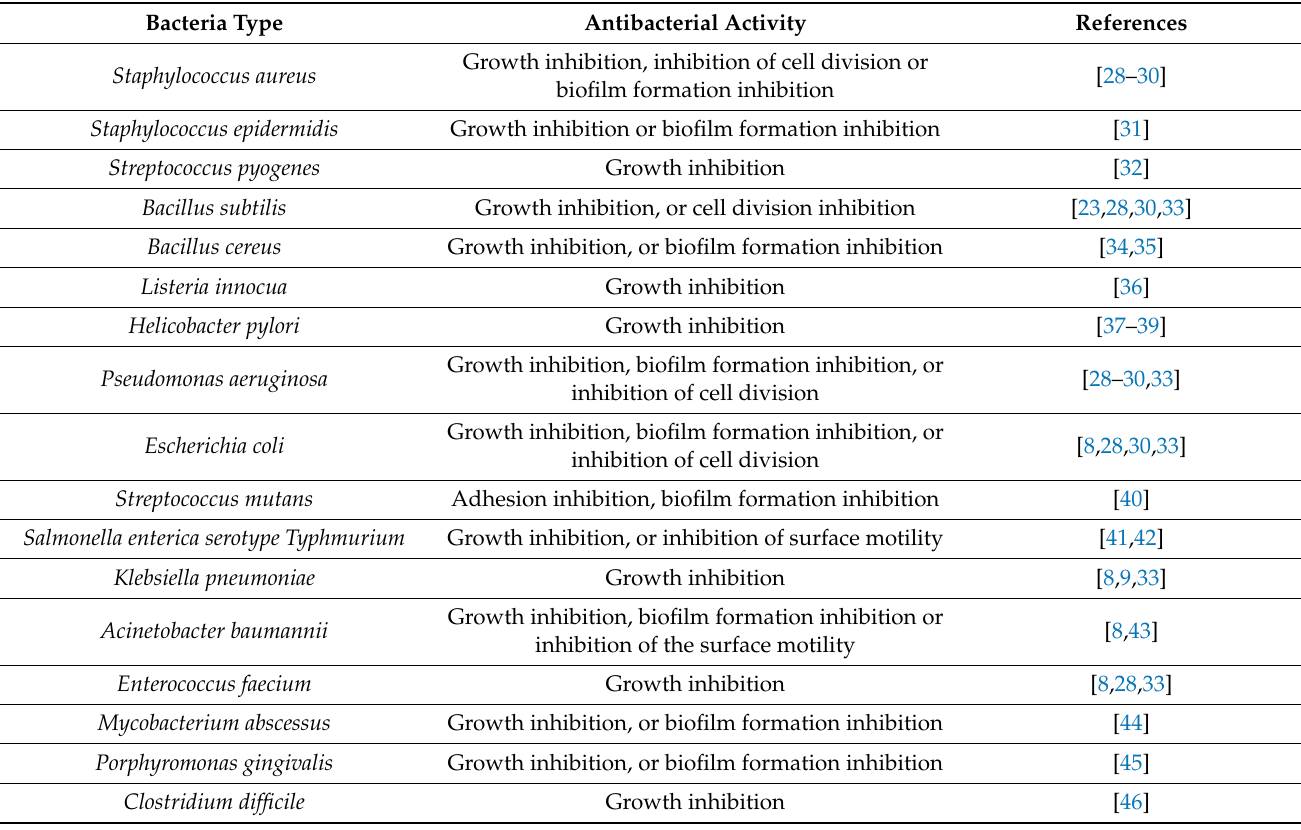
Table 1. Documented antibacterial activities of